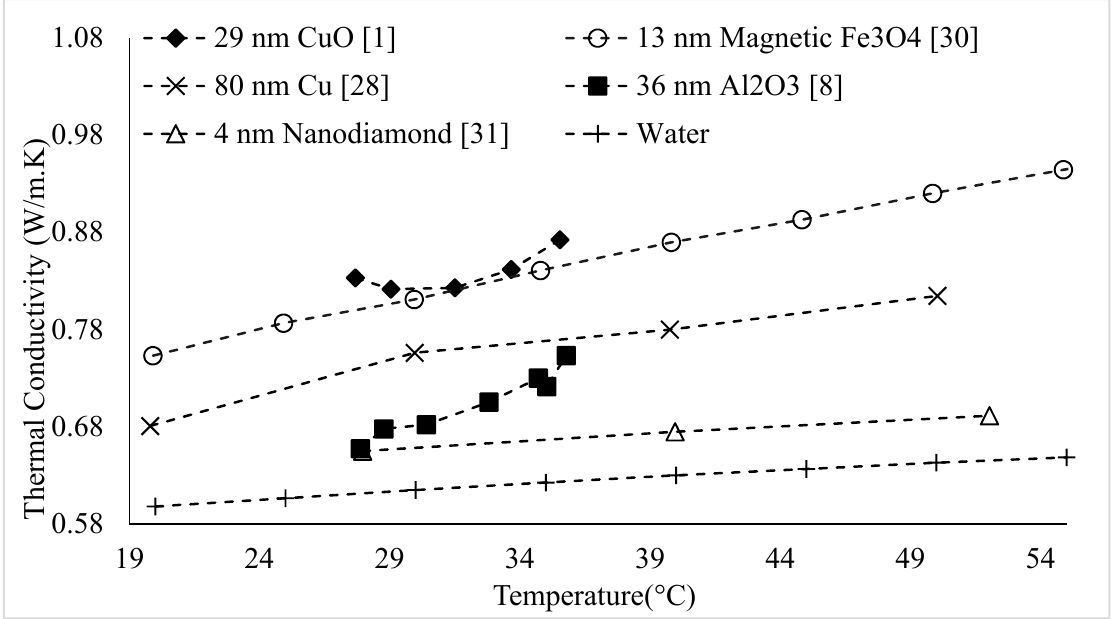
Figure 1. Variation of water-based nanofluid thermal conductivity as a function of temperature for different nanoparticles at ϕ = 2%.